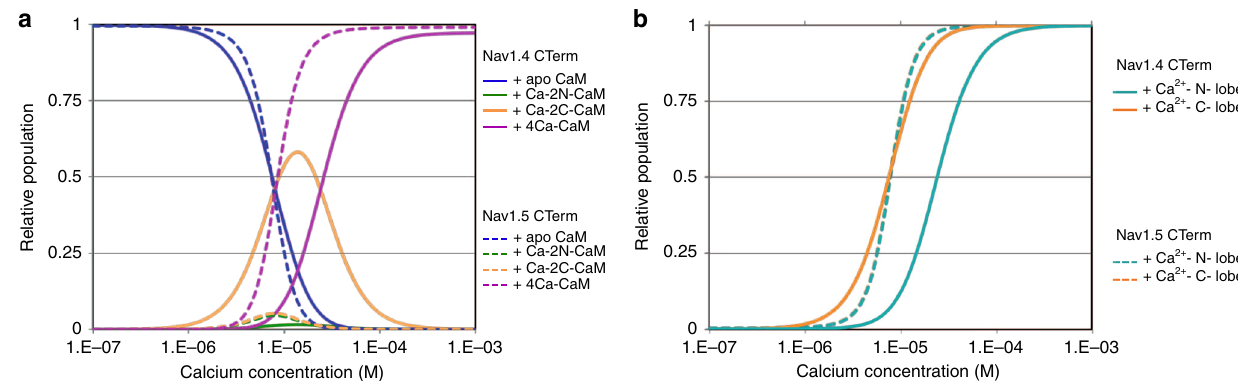
Fig. 5 Na V CTerm-CaM populations as a function of Ca 2 + . a The relative populations of four CaM-bound CTerm species are shown at a fi xed CaM concentration of 10 µ M ( fi xed CaM at 1 µ M shows similar trends, Supplementary Fig. 8). The isoform CTerm species add to 100%; free CTerm is included in calculations but not shown in fi gure. At ~10 µ M Ca 2 + Na V 1.4 CTerm shows a dominant species of (Ca 2 + ) 2-C – CaM bound to CTerm (solid orange line) while Na V 1.5 CTerm shows a dominant species of (Ca 2 + ) 4 – CaM bound to CTerm (dashed purple line). b The relative populations of CTerm-bound CaM, showing Ca 2 + -saturation of the CaM N- or C-lobe. At ~10 M Ca 2 + CaM bound to Na V 1.4 CTerm has little (Ca 2 + ) 2 -N-lobe (solid teal) while CaM bound to Na V 1.5 CTerm has primarily (Ca 2 + ) 2 -N-lobe (dashed teal line). This is consistent with the hypothesis that Na V 1.5 CTerm contains an NLBM while Na V .14